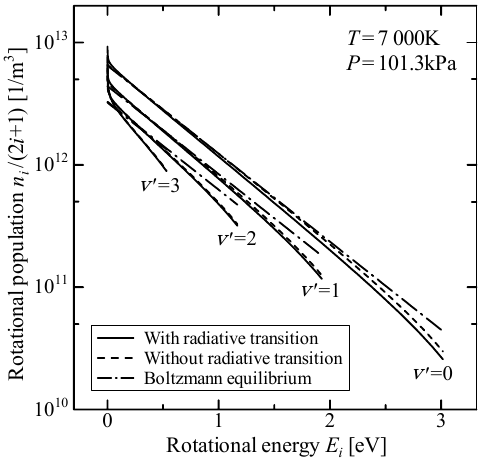
Fig. 6 Rotational population distribution